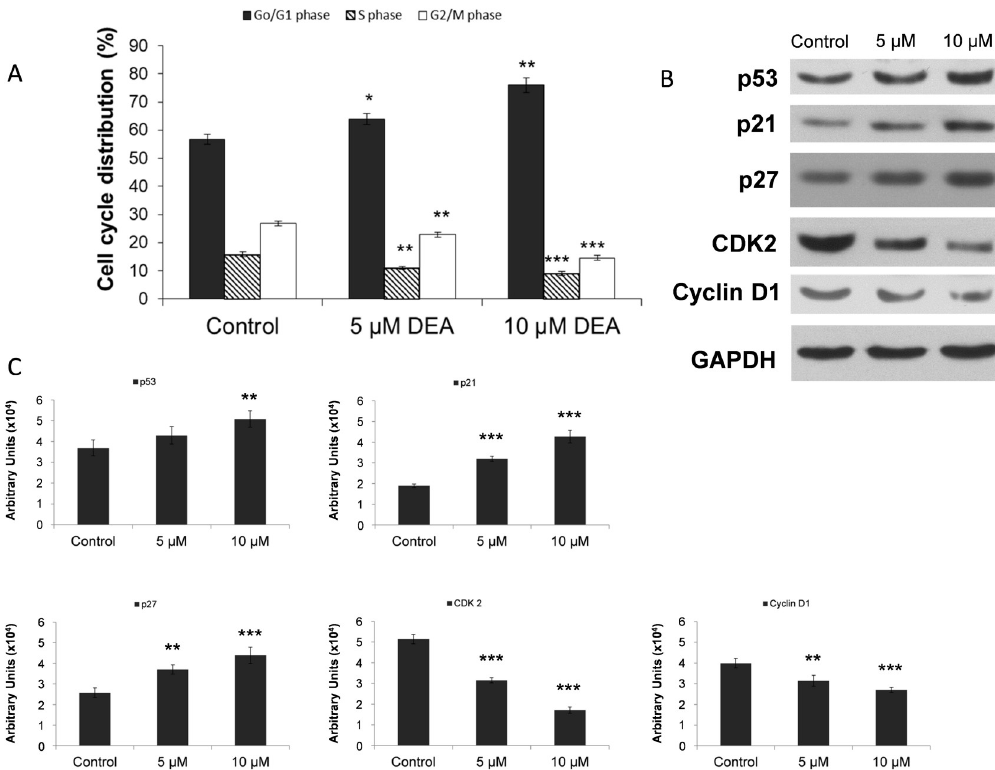
Fig 4. Effect of DEA on the cell cycle in B16-F10 melanoma cells. The cells were treated with different concentrations of DEA (0, 5 and 10 μ M) for 24 hours. Controls were treated with vehicle (0.2% DMSO). Then they were harvested, fixed with ethanol and stained with propidium iodide. DNA content was determined by Muse ™ Cell Analyzer. The results are presented as a bar diagram, percentage of cells in G0/G1 (dark grey bars), S (striped bars) and G2/M phases (white bars) of the cell cycle (A). Proteins from parallel cells were extracted for immunoblot analysis performed by using antibodies specific to p53, p21, p27, CDK2 and cylcin D1. GAPDH was used as a loading control. The results are presented as representative immunoblots (B) and densitometric analysis of immunoblots in bar diagrams (C). The results are mean ± SD of three independent experiments performed in at least quadruplicate. Data were analyzed using ANOVA with Dunett post hoc test (A) and with Mann- Whitney U test (C). � p � 0.05, �� p � 0.01 and ��� p � 0.001 compared to the corresponding control